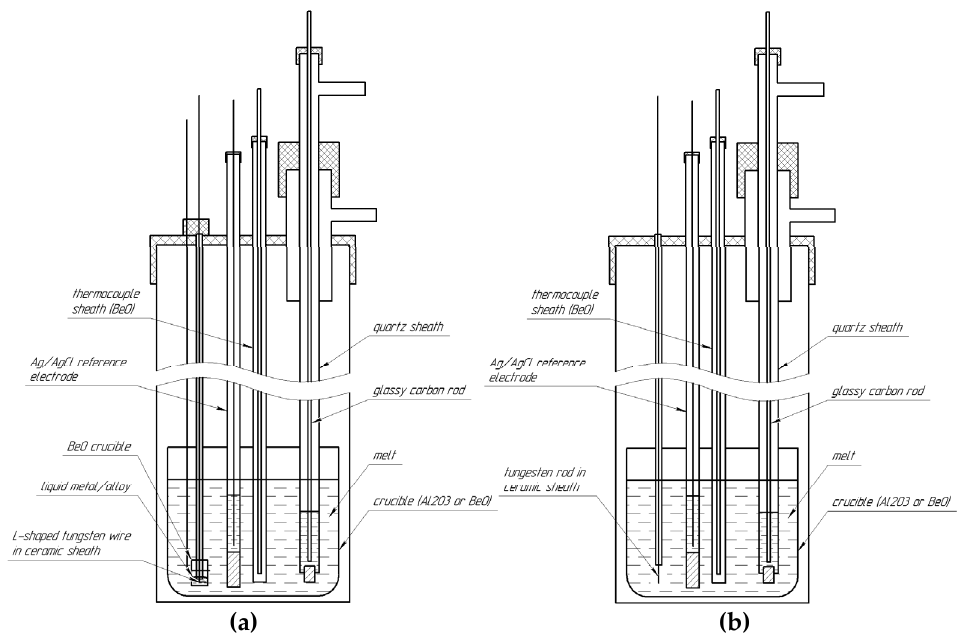
Figure 1. Experimental cells for studying polarization of liquid ( a ) and solid ( b ) metal cathodes in LiCl–KCl based melts.